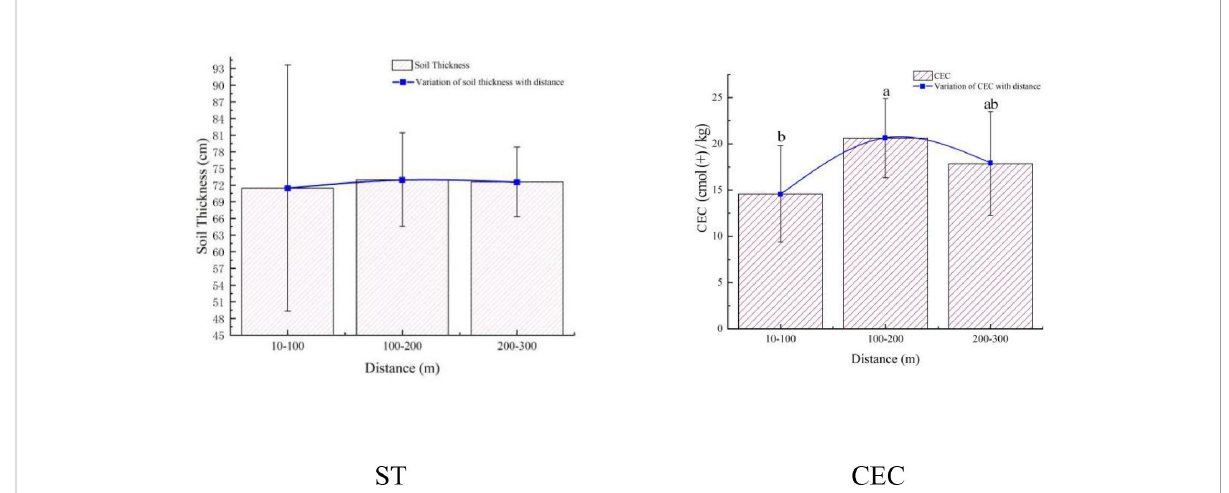
FIGURE 3 Changes in soil indices with different distances. The error rod is ± standard error.